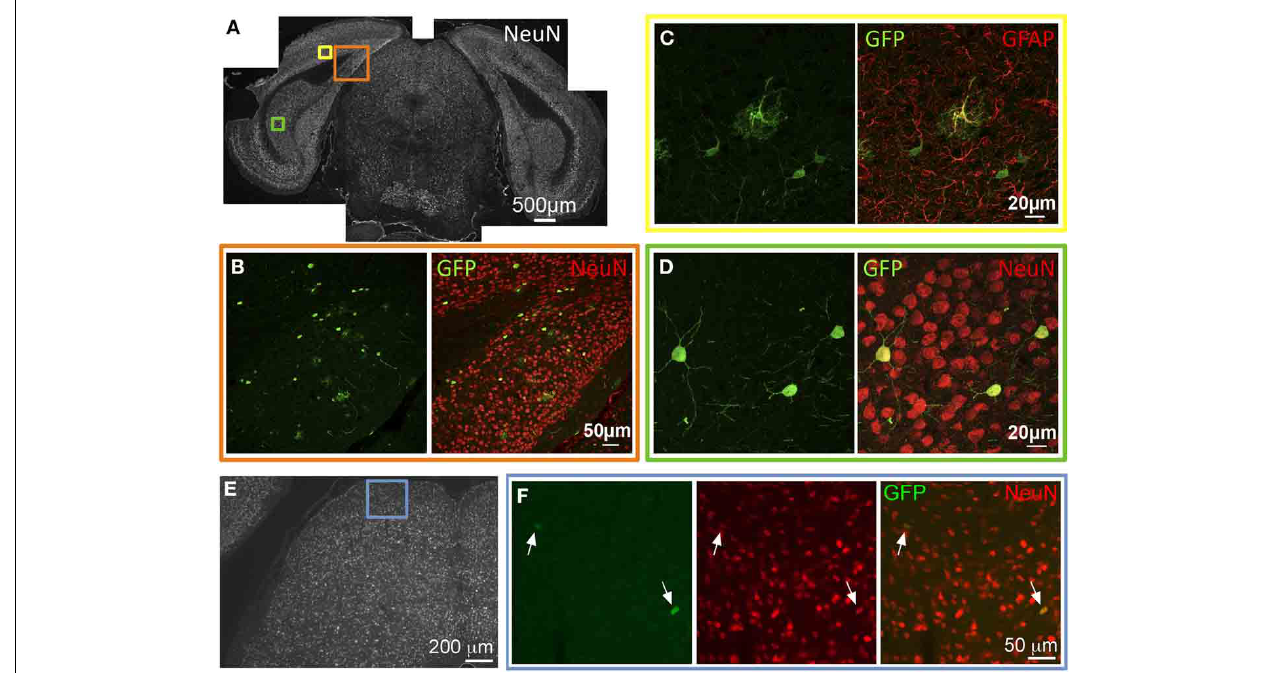
FIGURE 4 | GFP-ir in caudal cortex and midbrain. (A–D) Co-localization of GFP with neuronal and astroglial markers in caudal cortex. (A) Low magnification image of NeuN-ir and colored inset boxes illustrate the locations of images in (B–D) (approximately − 4.2mm Bregma). (B) GFP-ir in cells across areas of primary visual cortex (v), retrosplenial cortex (rs),